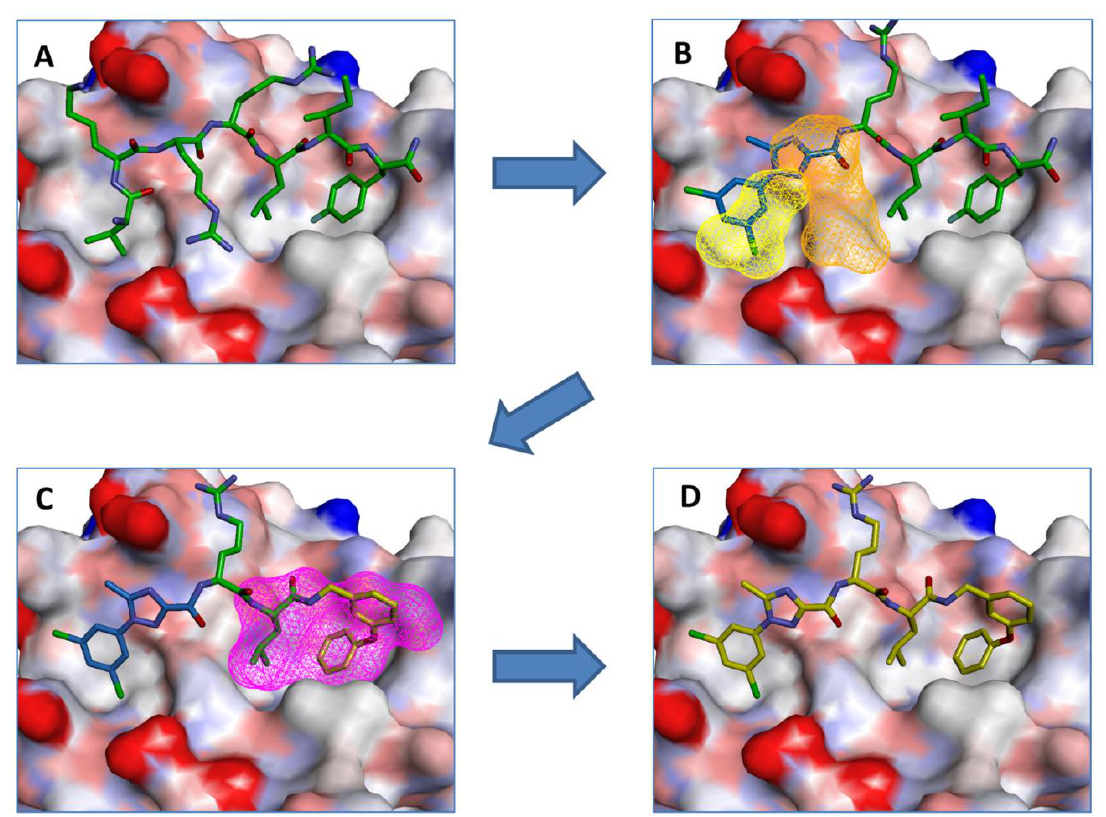
Figure 1. Example of the REPLACE protocol utilized to convert the peptide sequence HAKRRLIF to an N-capped and C-capped dipeptide (PDB ID: 2UUE). ( A – C ). Peptide HAKRRLIF docked to a hydrophobic pocket. ( D) . The modified peptide. Used with permission [17].